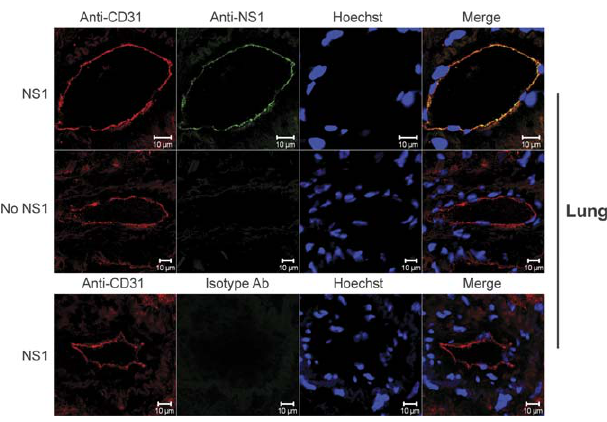
Figure 9. Binding of DENV NS1 to Human Lung Cryo-sections of human lung tissue were incubated with 20 l g/ml of purified DENV-2 NS1 or BSA for 1 h at room temperature. Bound NS1 was detected by staining with a mixture of DENV NS1 mAbs (1A4, 1F11, 2G6, 1B2) followed by Alexa Fluor 488 conjugated with goat anti-mouse IgG. Subsequently, the sections were co-stained with rabbit anti-human CD31 (PECAM-1) followed by Cy3-conjugated donkey anti-rabbit IgG. Nuclei were stained with a DNA-specific dye (Hoechst) and the sections were analyzed by confocal microscopy. Sections incubated with purified DENV NS1 and stained with isotype mAbs served as a negative control.